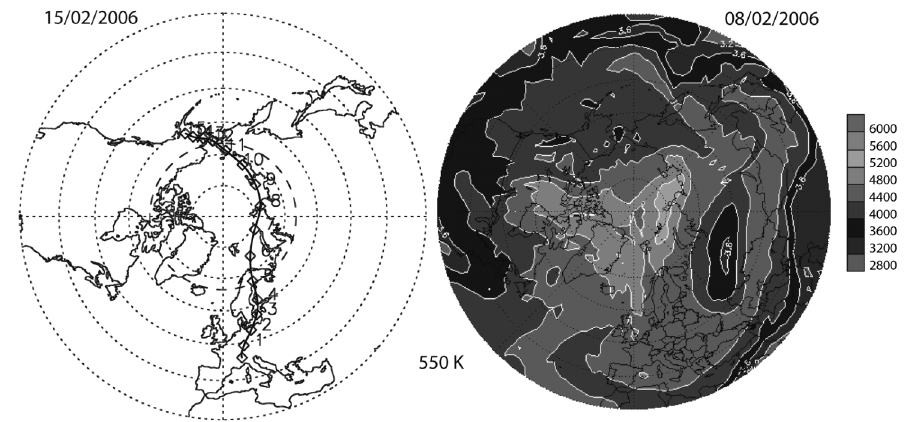
Fig. 10. NASA/GSFC 15-day back trajectory at 550 K ( ∼ 25 km altitude) arriving over Testa Grigia on 15 Feb- ruary, 2006 ( left ) and an ozone mixing ratio contour map at 550 K for 8 February, 2006 ( right ) produced by the REPROBUS model calculations downloaded from